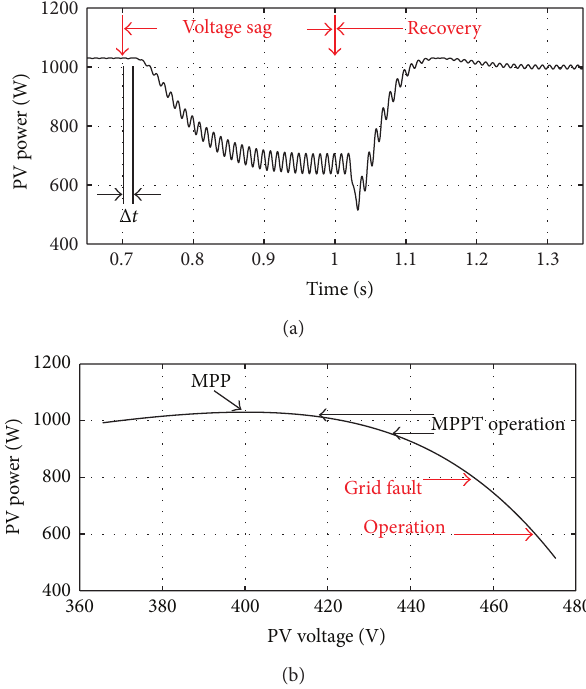
Figure 13: Simulation results for a single-phase PV system under grid fault: (a) PV panel output power; (b) PV panel output power versus its voltage.